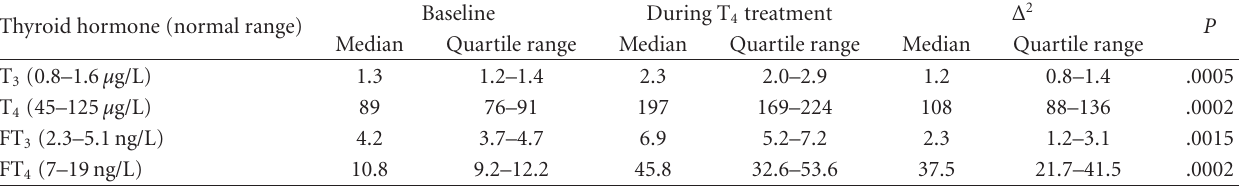
Table 1: Serum concentrations of thyroid hormones at baseline and during maximal dosage of levothyroxine (L-T4) 1 . Thyroid hormone (normal